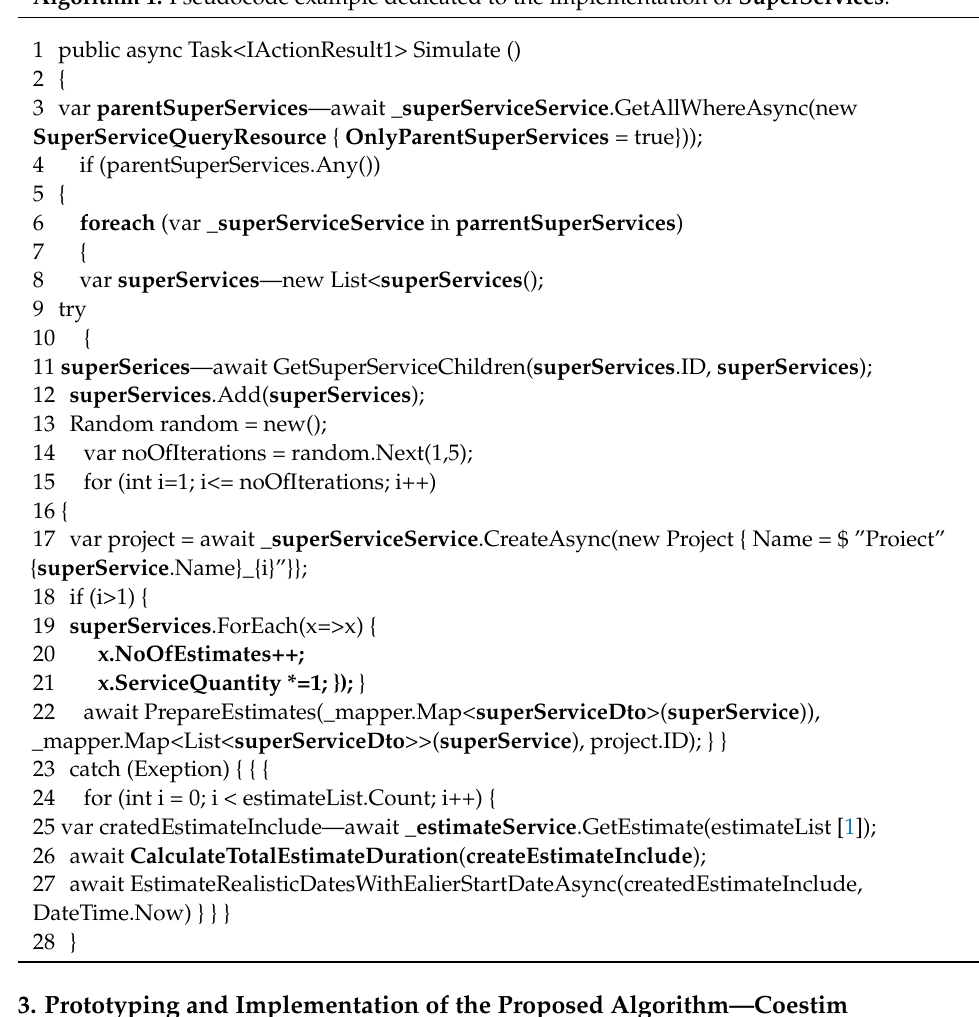
Algorithm 1: Pseudocode example dedicated to the implementation of SuperServices